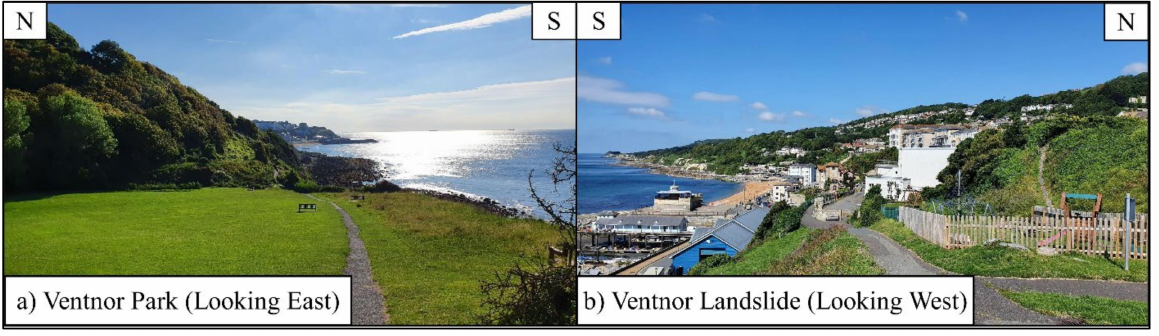
Figure 5. ( a , b ): Ventnor Park ( a ) where vegetation is present and hence a lack of PS generators. Image ( b ) shows the abundance of PS generators (houses, fences, walls etc.) resulting in the greater density of points toward the east as shown in Figure